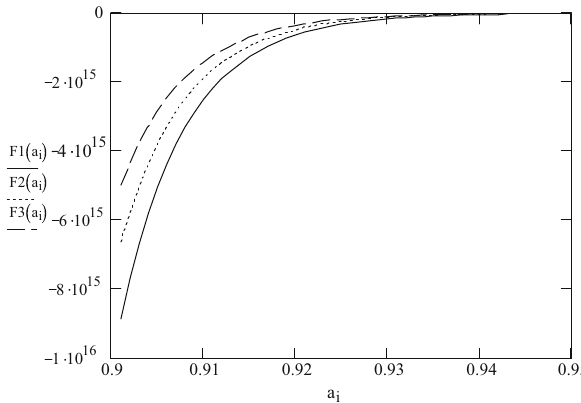
Fig. 1 The solid, dotted, and dashed curves of the Casimir force per unit area between two parallel plates as a function of plate separation a for β = 0 . 0101 , 0 . 01005 , and 0 . 01 with HL factor z = 2 .